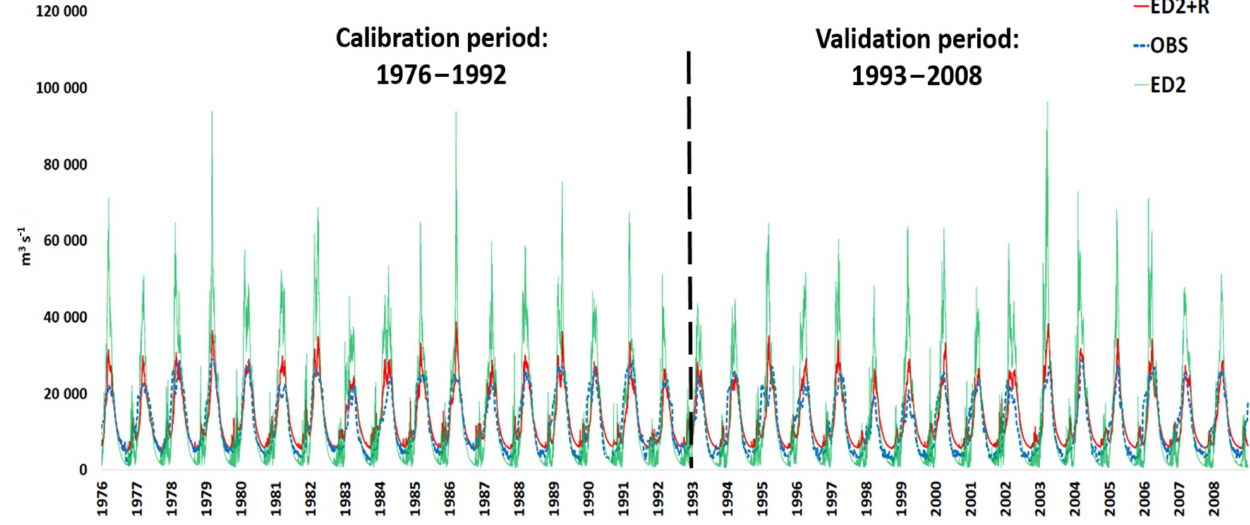
Figure 8. Calibration and validation of the river flow (m 3 s − 1 ) at Itaituba (farthest downstream river gauge – Lower Tapajós sub-basin). ED2 output (green line), ED2 + R (red line), and observations (blue dotted line). The dotted black line splits the calibration and validation periods. Similar comparison for each of the seven sub-basins is available in Appendix